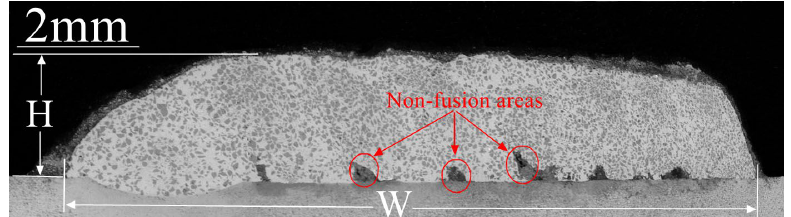
Figure 4. Macrograph of cross-section multi-pass clad